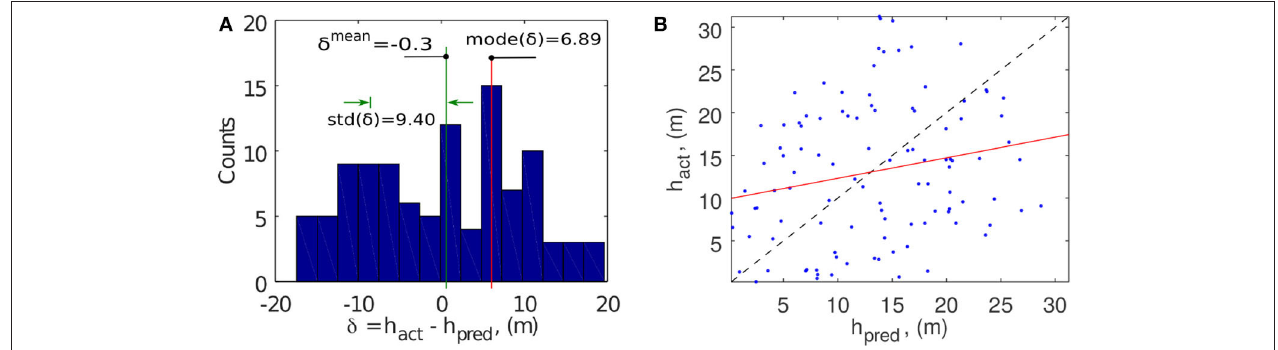
FIGURE 9 | Landslide FID18. (A) Histogram of δ ( x , y ) and the graphical definition of mode( δ ), std( δ ) and the negligible mean depth discrepancy δ mean . (B) Scatter plot and regression analysis of the predicted and actual depths.